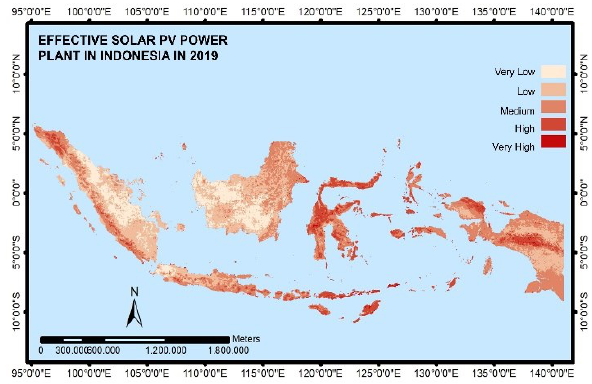
Figure 3 . Meteorology Aspect